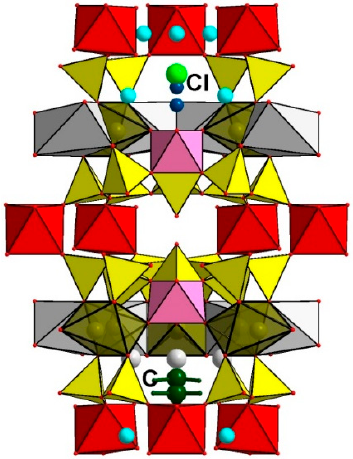
Figure 9. Blocky isomorphism in the M 3 and M 4 micro-regions of golyshevite viewed along (210).